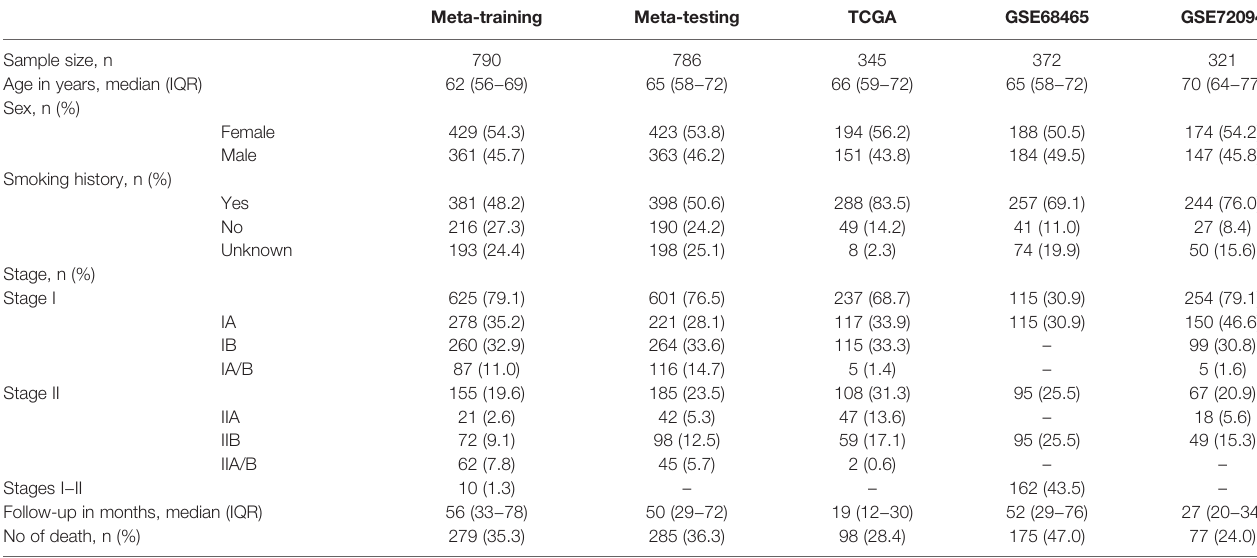
TABLE 1 | Clinical and pathologic features of patients in meta-training, meta-testing, and independent validation